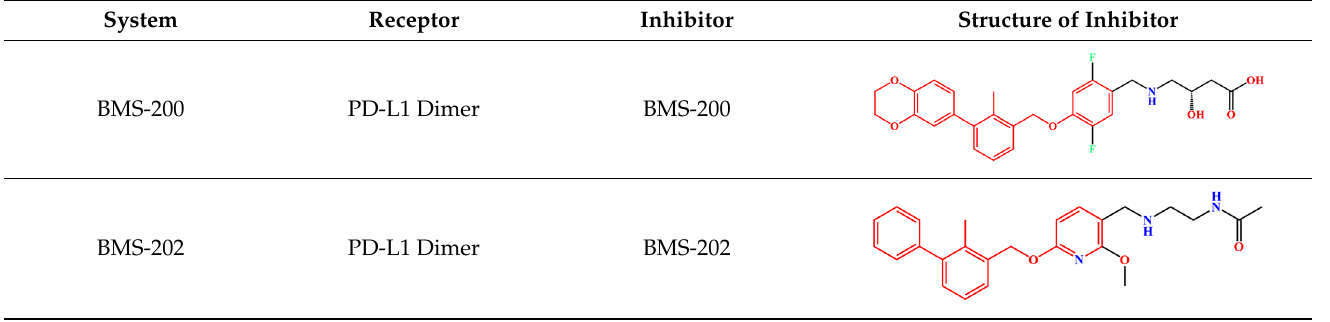
Table 1. An overview of the investigated systems in this work.